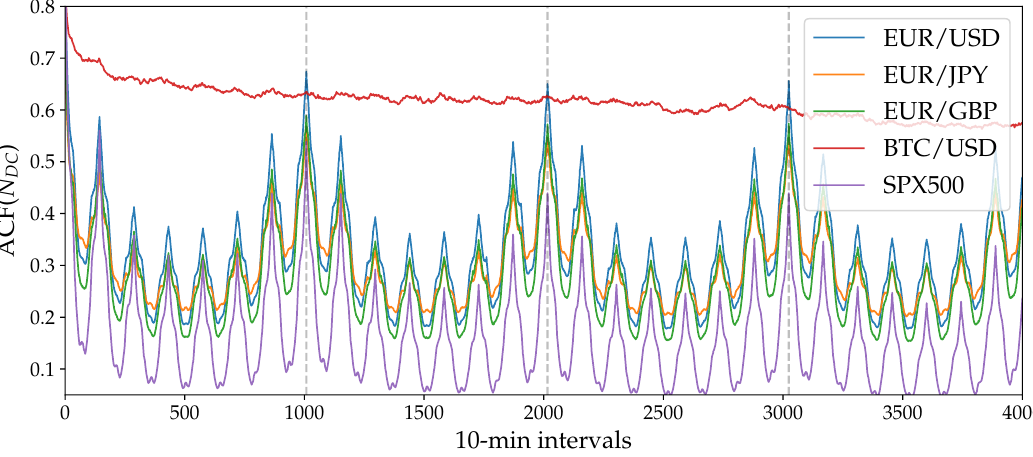
Figure 13. Autocorrelation function of the number of directional changes per 10-min long bins computed in physical time. Vertical dashed lines label weekly intervals. Applied threshold δ =